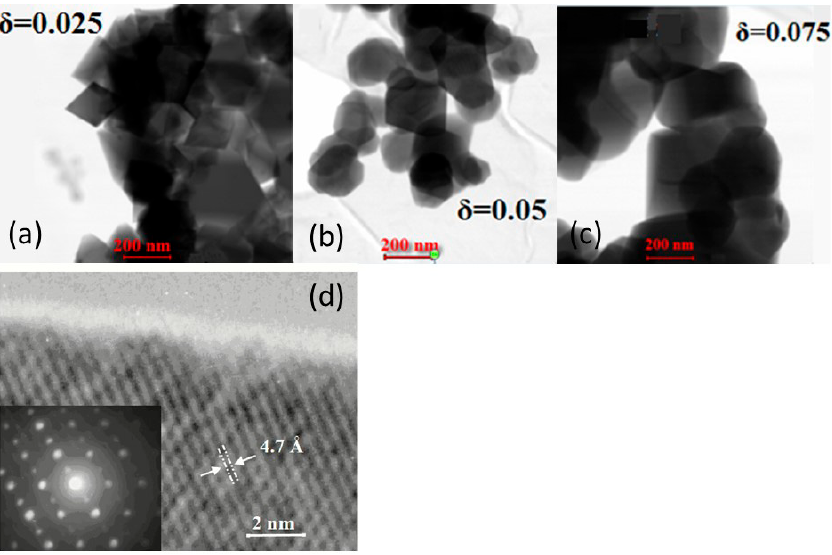
Figure 17. ( a – c ) TEM images of individual LiNi 0.33+ δ Mn 0.33+ δ Co 0.33-2 δ O 2 nanoparticles with δ = 0.025, 0.05, and 0.075, respectively; ( d ) HRTEM image of a nanoparticle ( δ = 0.025) showing lattice fringes consistent with the interspacing of the (003) planes of the R 3 m layered structure.